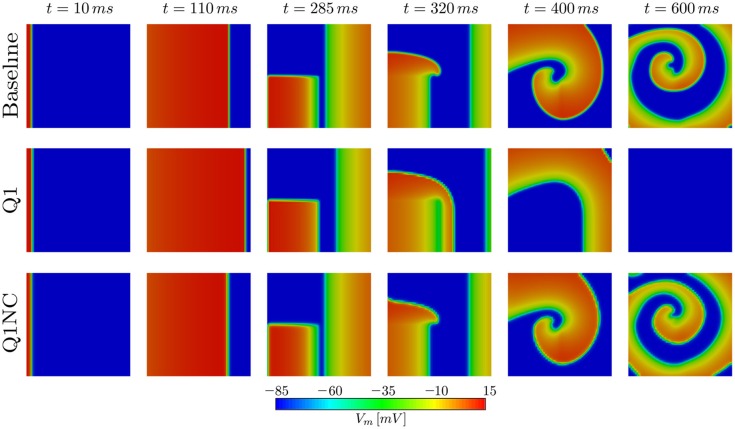
Spiral generation simulation in a 2D slab. Due to the higher CV, the Q1 case (coarse mesh) cannot capture the genesis of the spiral wave.